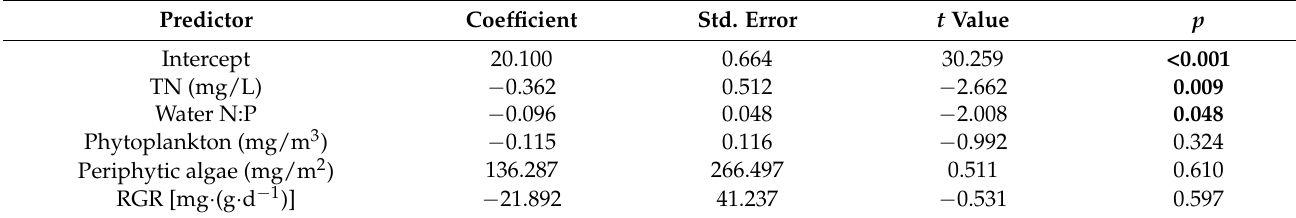
Table 5. Summary of the best model of the relationship between V. natans C:N and water N:P.